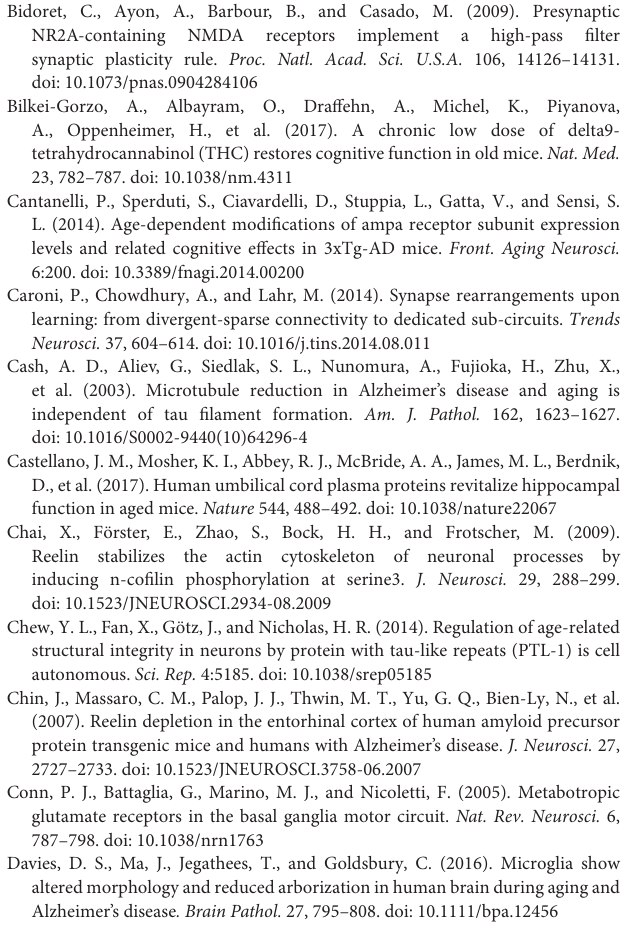
and figure design. ML-M, NP-B, MB, JP, and AR-M: Manuscript writing, editing and synthesis of previous